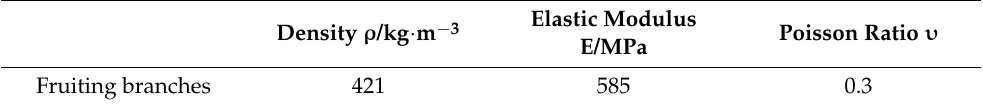
Table 1. Simulation